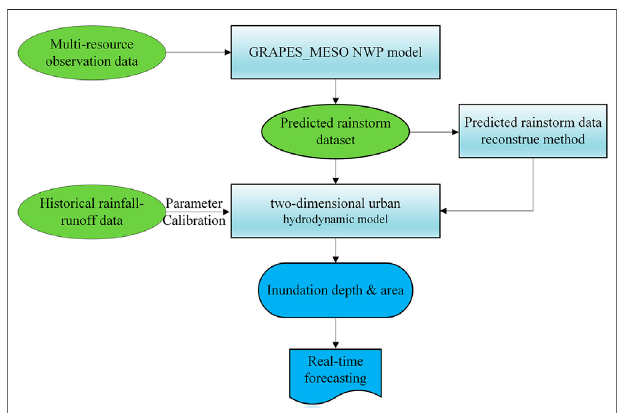
FIGURE 3 | Flowchart of the urban fl ood inundation forecasting